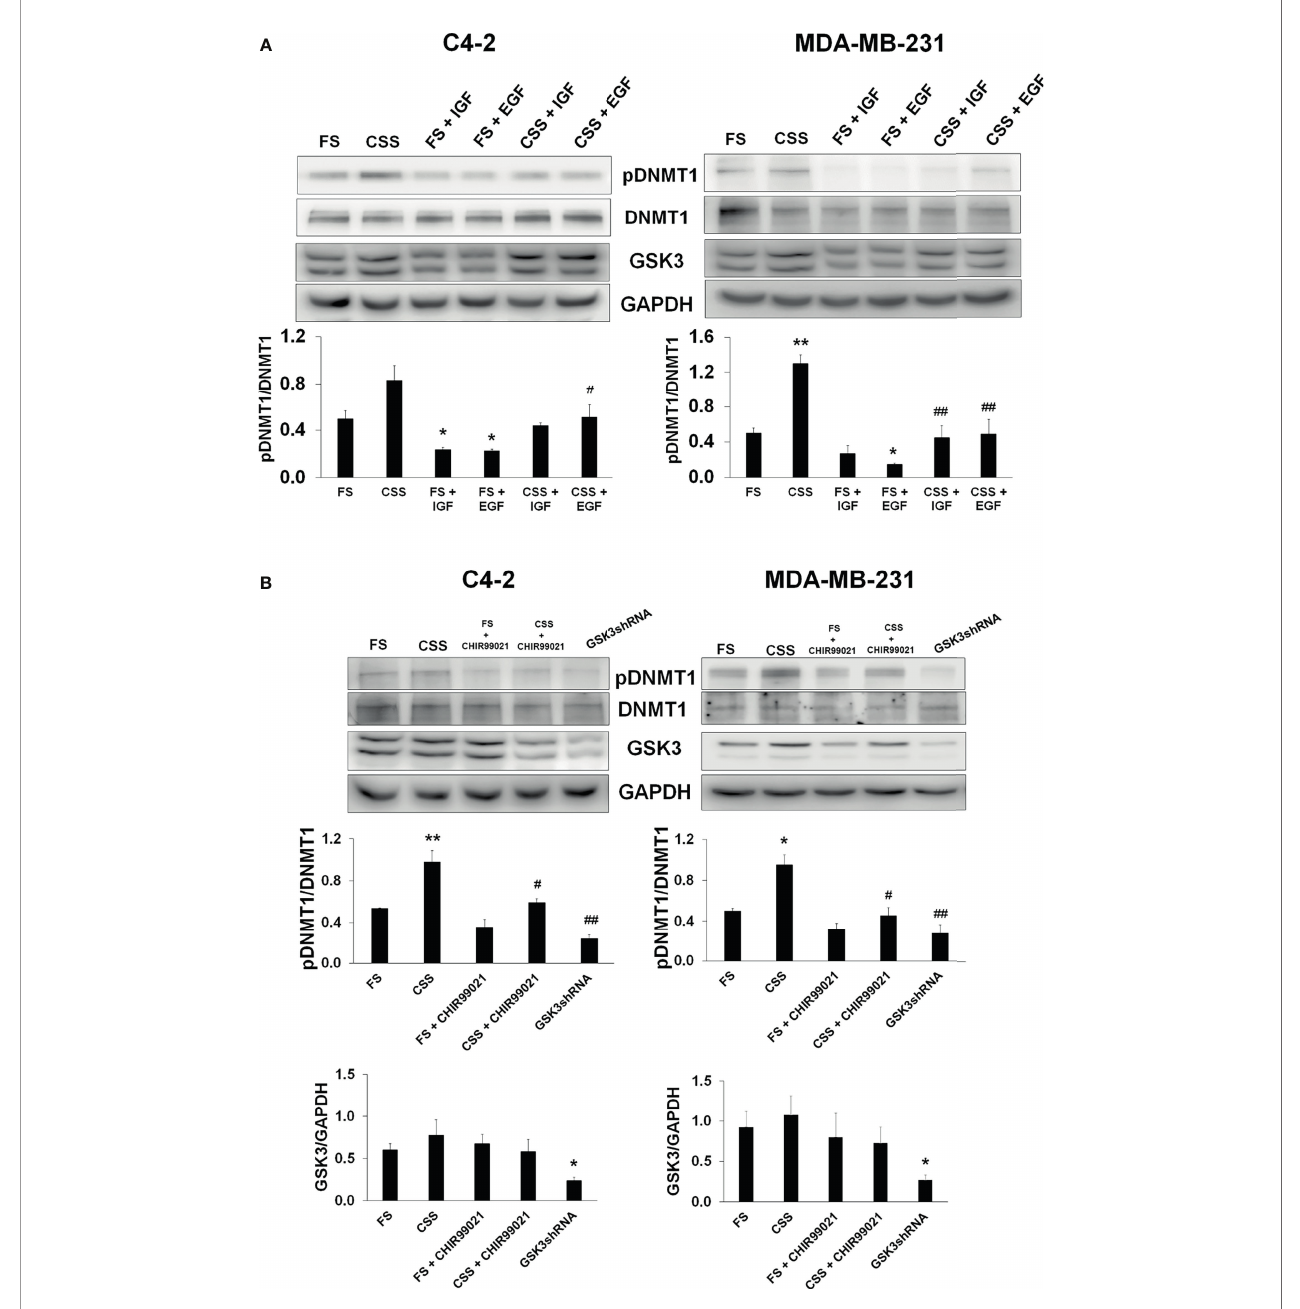
FIGURE 7 | Inhibition of GSK3-mediated DNMT1 phosphorylation by growth factors. (A) C4-2 and MDA-MB-231 were grown in media supplemented with Full Serum (FS) or Charcoal Stripped Serum (CSS) and treated with either IGF (1 µM, 4 h) or EGF (1 µM, 4h). Cells were processed for western blot analyses of expression of pDNMT1 and GSK3 normalized to DNMT1 and GAPDH. Figures are representative of at least 3 independent experiments. *P<0.05 and **P<0.01 vs . FS. # P<0.05 and ## P<0.01 vs . CSS. (B) C4-2 and MDA-MB-231 cells were grown in media supplemented with Full Serum (FS) or Charcoal Stripped Serum (CSS) treated with GSK3 inhibitor (CHIR99021) or transfected with GSK3 shRNAs targeting GSK3 a and GSK3 b . Cells were processed for western blot analyses of indicated proteins normalized to GAPDH. Figures are representative of at least 3 independent experiments. *P<0.05 and **P<0.01 vs . FS. # P<0.05 and ## P<0.01 vs .